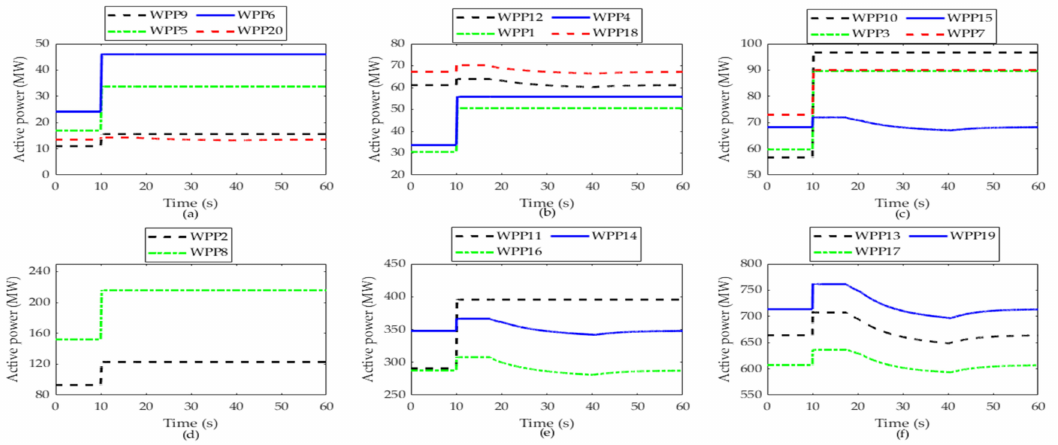
Figure 8. Output power from each WPP for case study 1. ( a ) WPP5, WPP6, WPP9, WPP20, ( b ) WPP1, WPP4, WPP12, WPP18, ( c ) WPP3, WPP7, WPP10, WPP15, ( d ) WPP2, WPP8, ( e ) WPP11, WPP14, WPP16, and ( f ) WPP13, WPP17, WPP19.